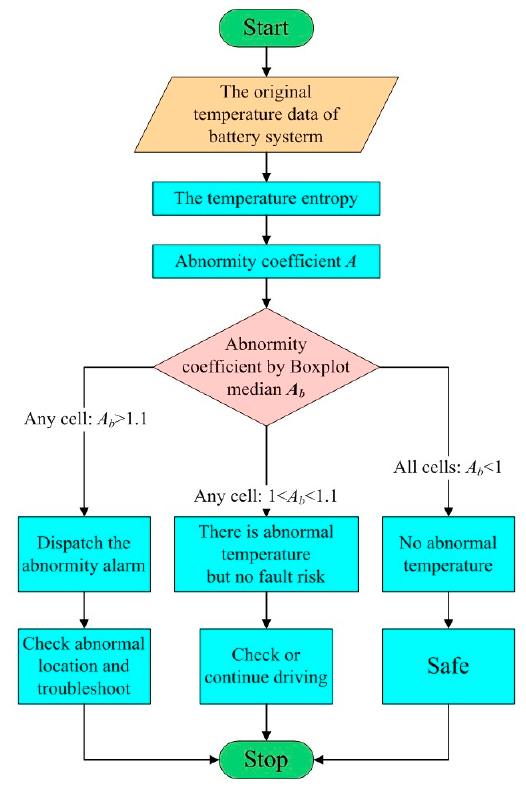
Figure 16. The prognosis strategy flowchart of a thermal